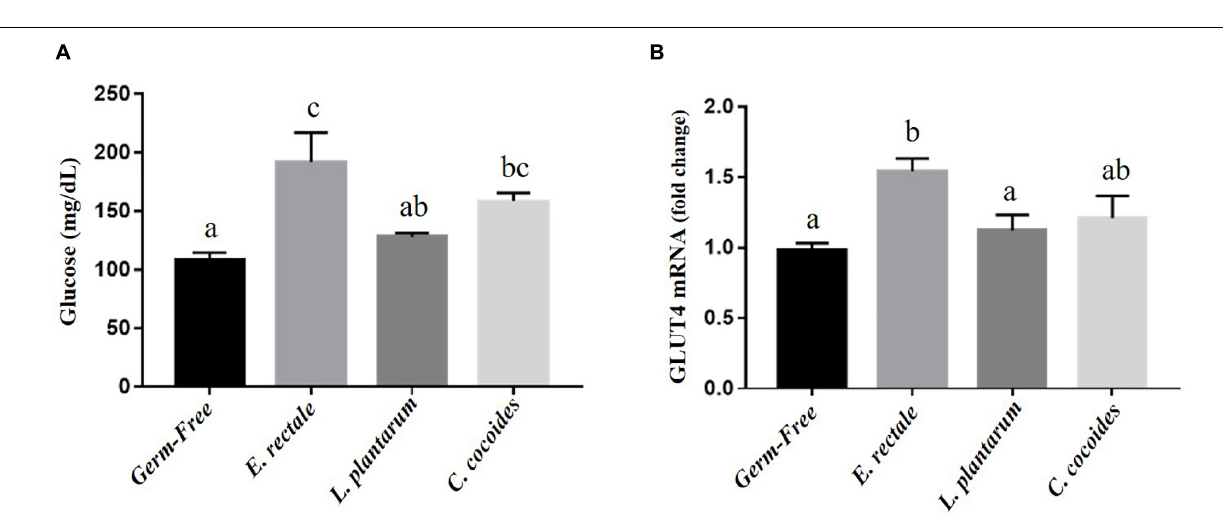
affect glycogen content in the liver [ Figure 7A ; F (4,32) = 4.18, P = 0.008] but not in muscles [ Figure 7B ; F (4,32) =